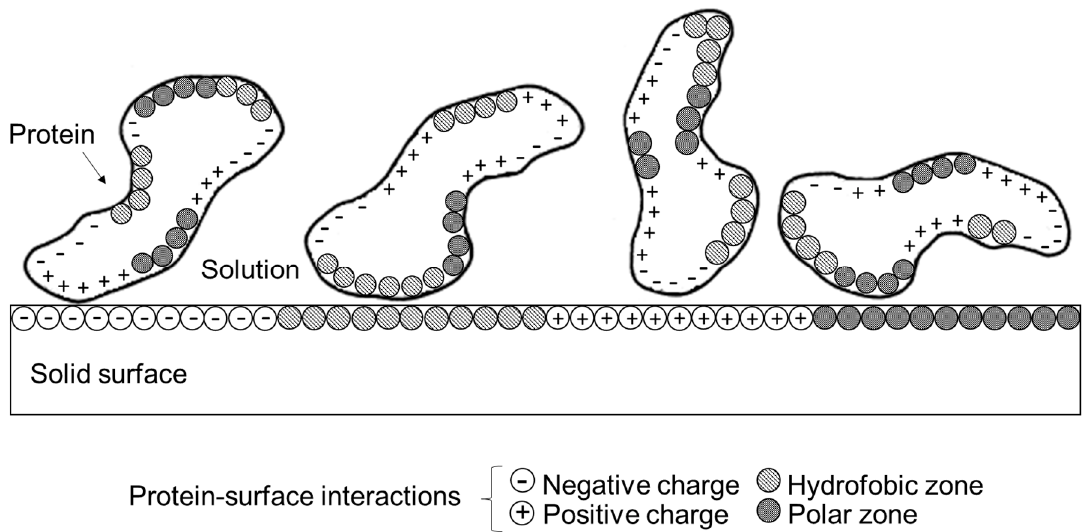
Figure 4. Protein-Surface Interactions Figure 4. Protein ‐ Surface Interactions [72].